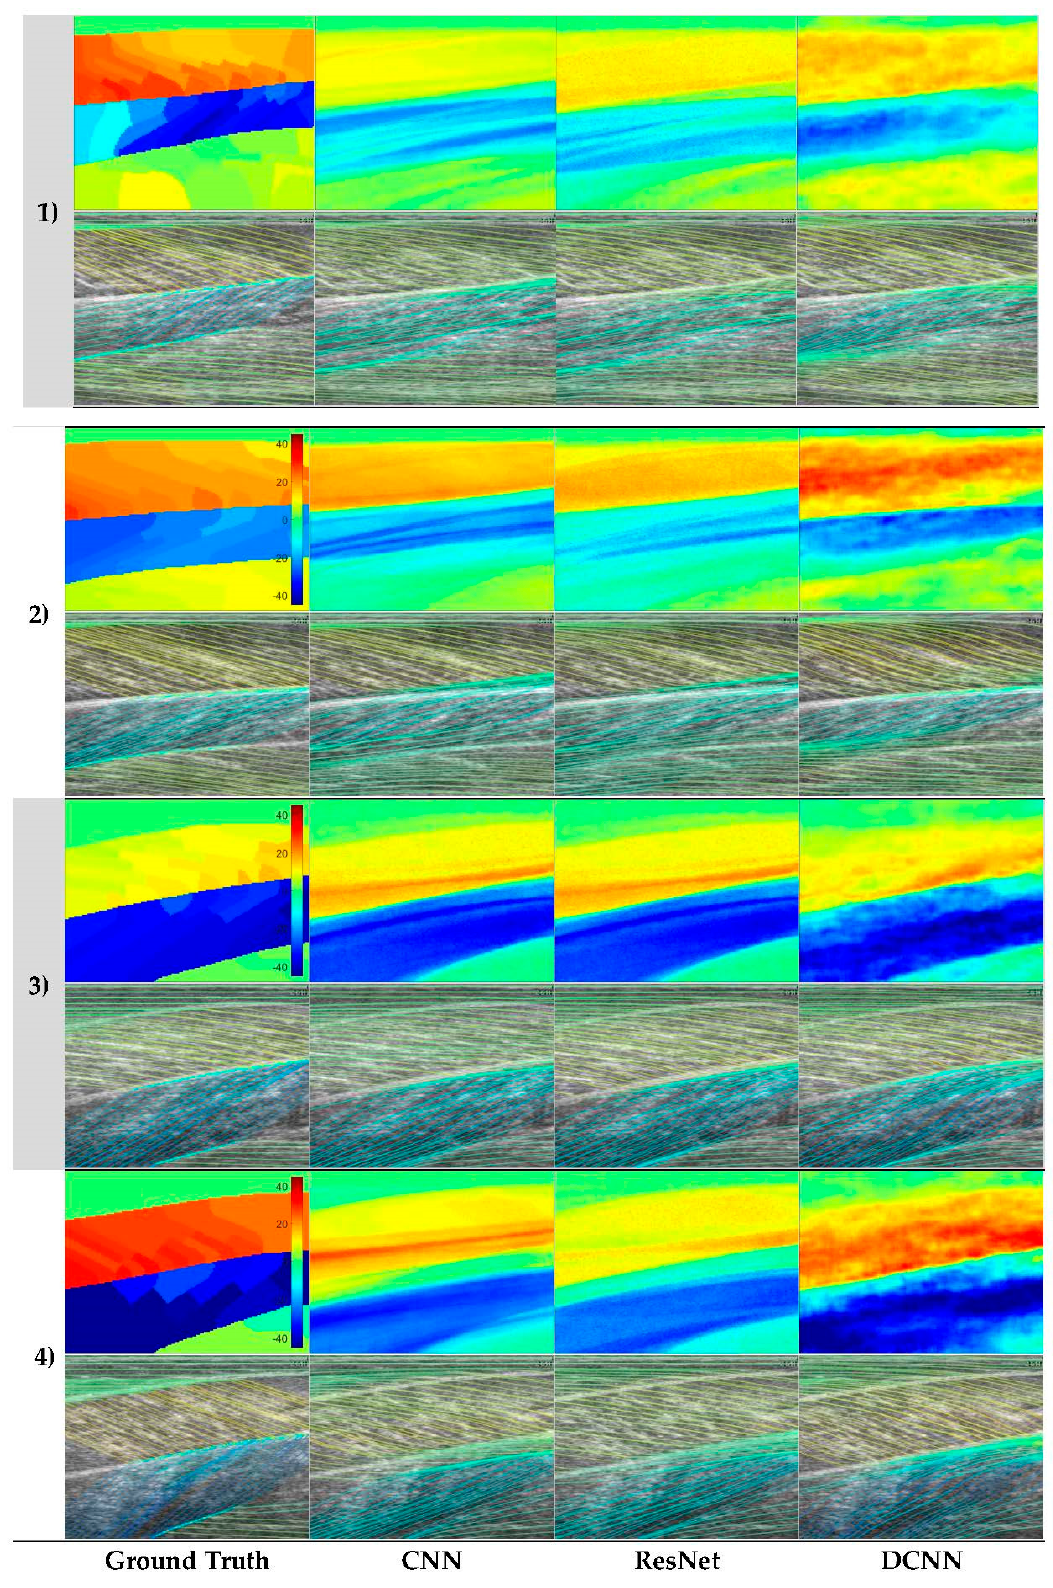
Figure 5. Representative neural network predictions. Rows 1–4 show four respective test participants in the dataset. In each row, the top image shows a fibre orientation heatmap and the bottom image shows a line trace representation of the heatmap, overlaid on the ultrasound image. Columns show respectively, ground.